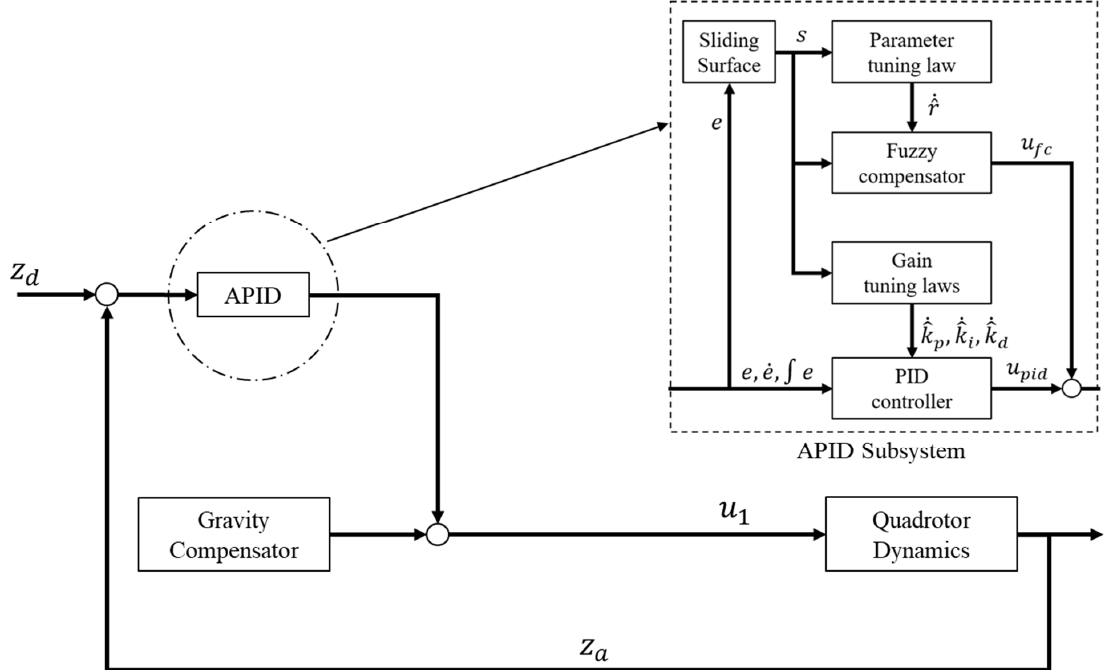
Figure 3. Adaptive PID controller for an altitude controller block diagram.